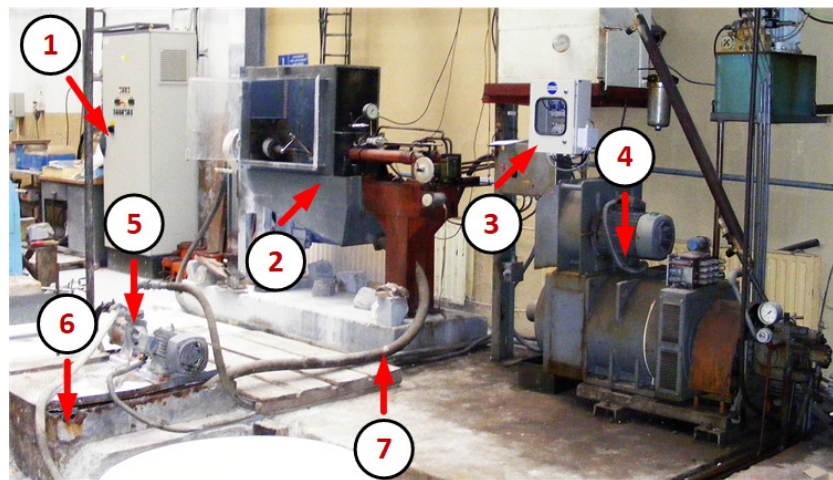
Figure 2. Main parts of the drilling stand ( 1 —Power switchboard, 2 —experimentally drilling machine, 3 —measuring system ADASH, 4 —hydroelectric generator, 5 —water pump, 6 —sludge pit, 7 —hose for outfall of drilling fluid).